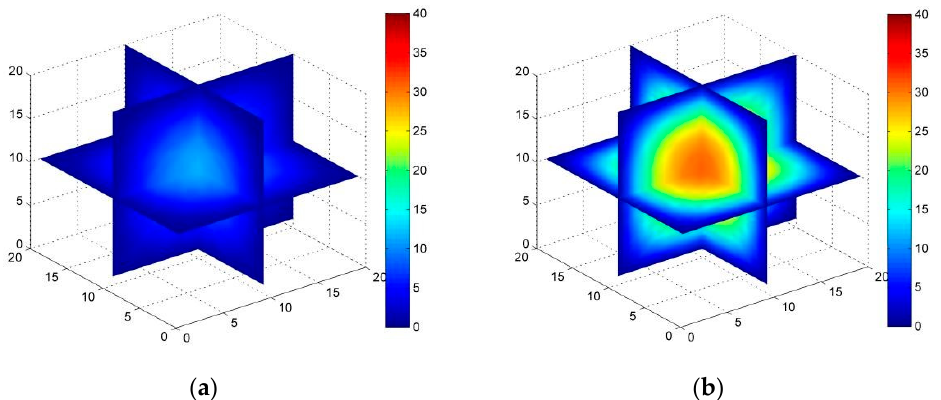
Figure 5. Dense matrix pore network model. ( a ) Matrix block generated by the algorithm, and ( b ) pore network inside the matrix block.